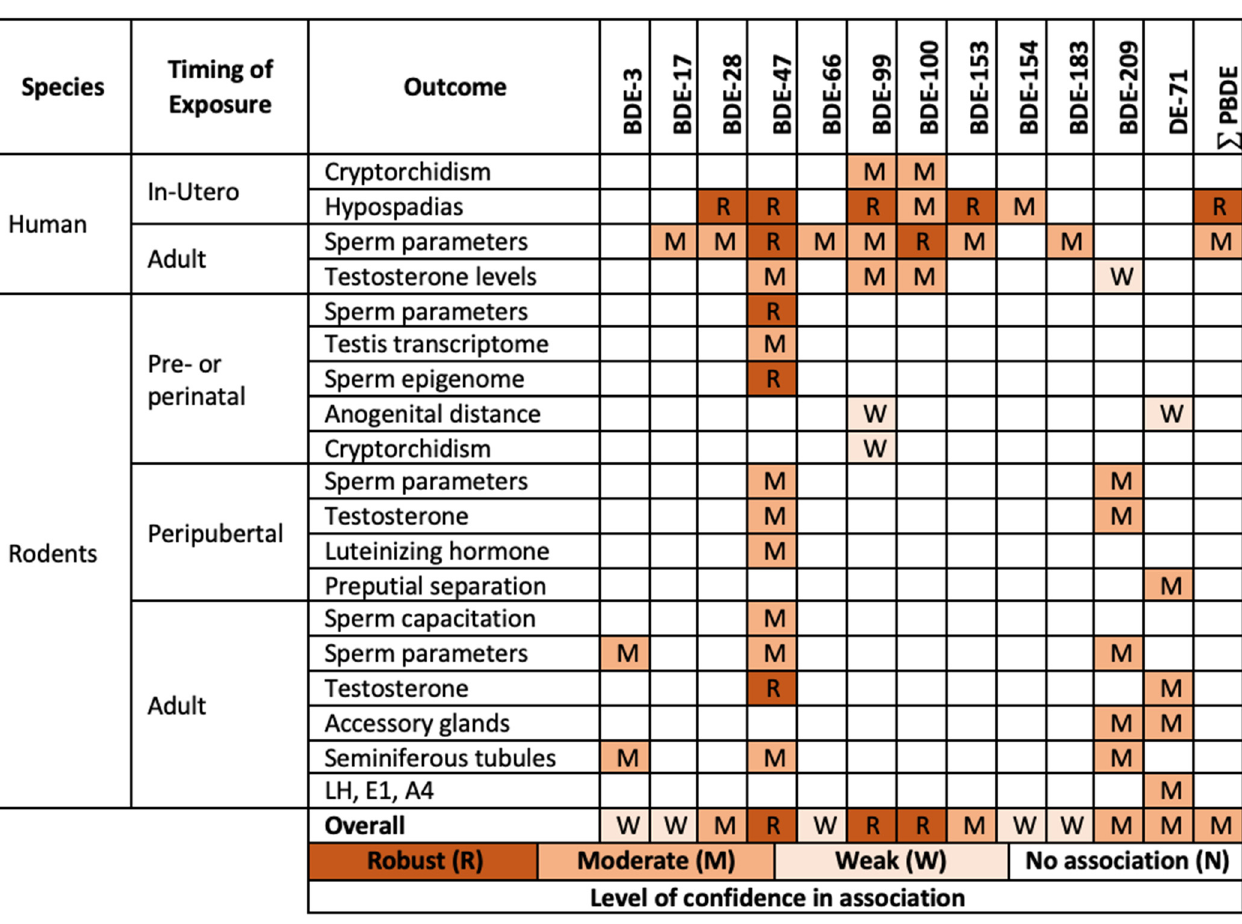
Figure 1. Summary of epidemiologic and experimental evidence of male reproductive effects associated with PBDEs. Findings may be biased due to different coverage of PBDE congeners by published research.